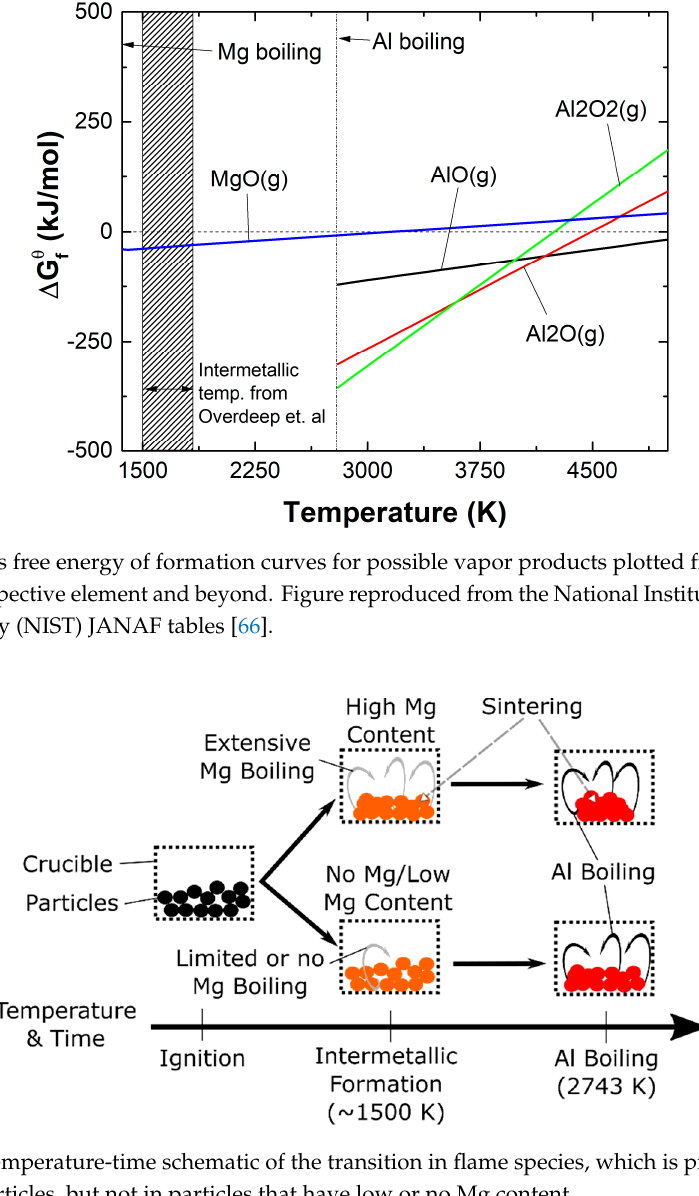
Figure 10. A temperature-time schematic of the transition in flame species, which is present in higher Mg content particles, but not in particles that have low or no Mg content. Mg content particles, but not in particles that have low or no Mg